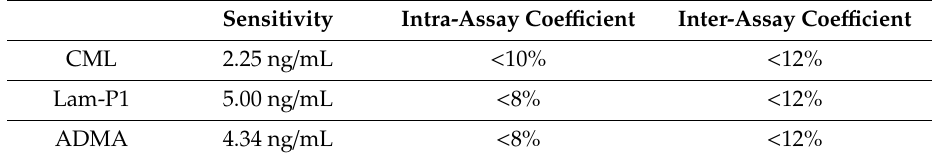
Table 1. Sensitivity and intra- and inter-assay coe ffi cients of the measured circulating biomarkers. Sensitivity